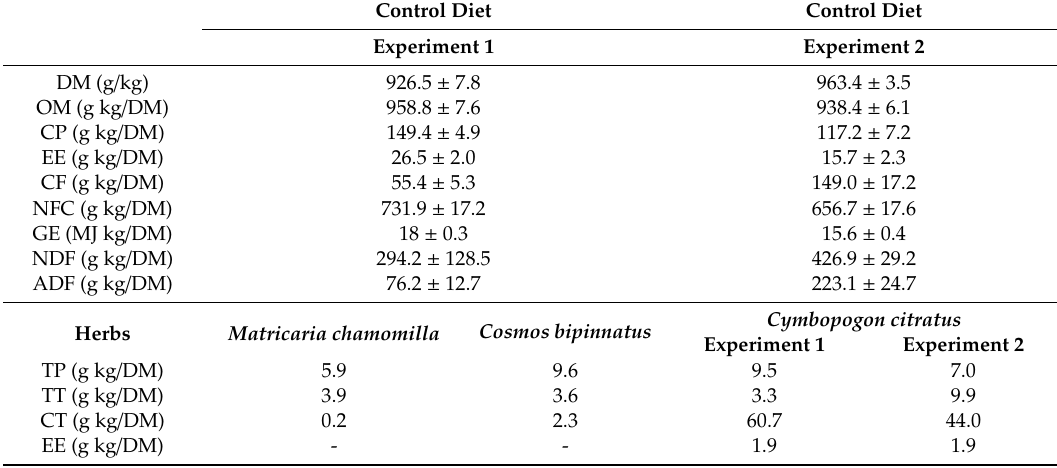
Table 1. Chemical composition of the control diets used in Experiments 1 and 2 and polyphenol and tannin contents of the herbs used for Experiments 1 and 2 to reduce enteric methane emissions in beef